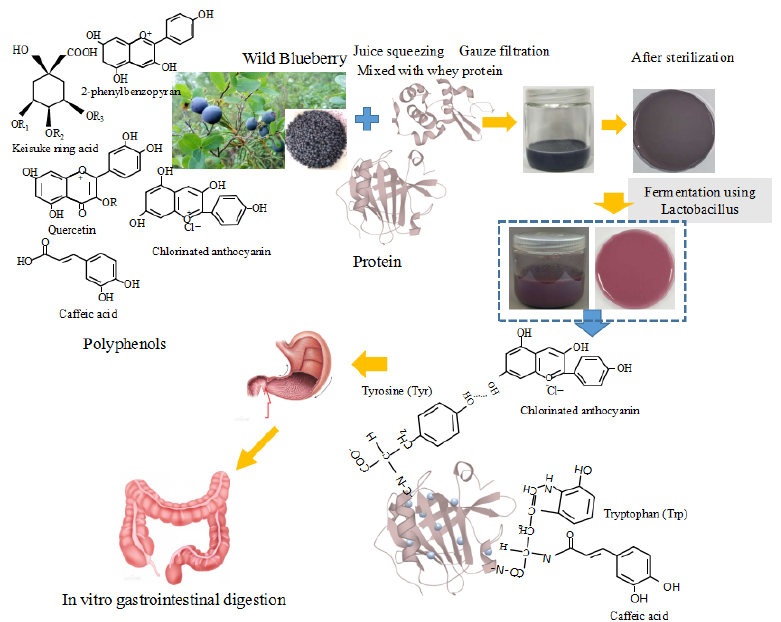
Figure 1. Schematic diagram showing preparation and analysis of blueberry juice and whey protein fermentation system with L. plantarum 67 and L. casei 54.